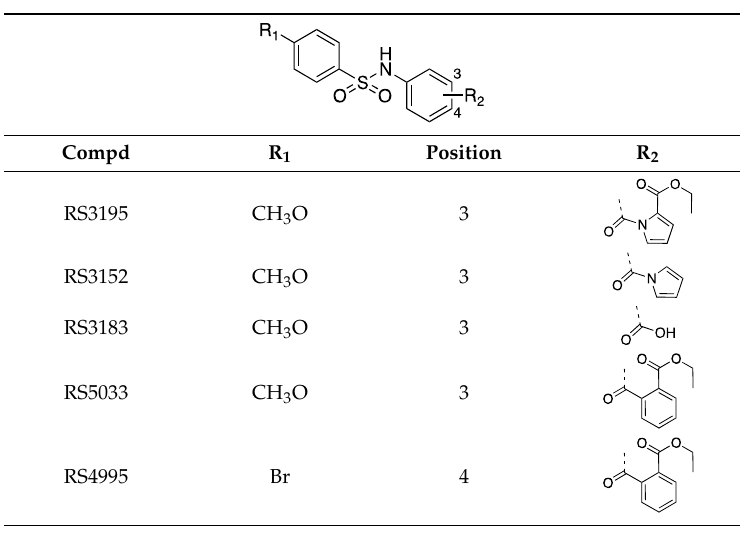
Table 1. Chemical structures for RS compounds 3195, 3152, 3183, 5033 and 4995.